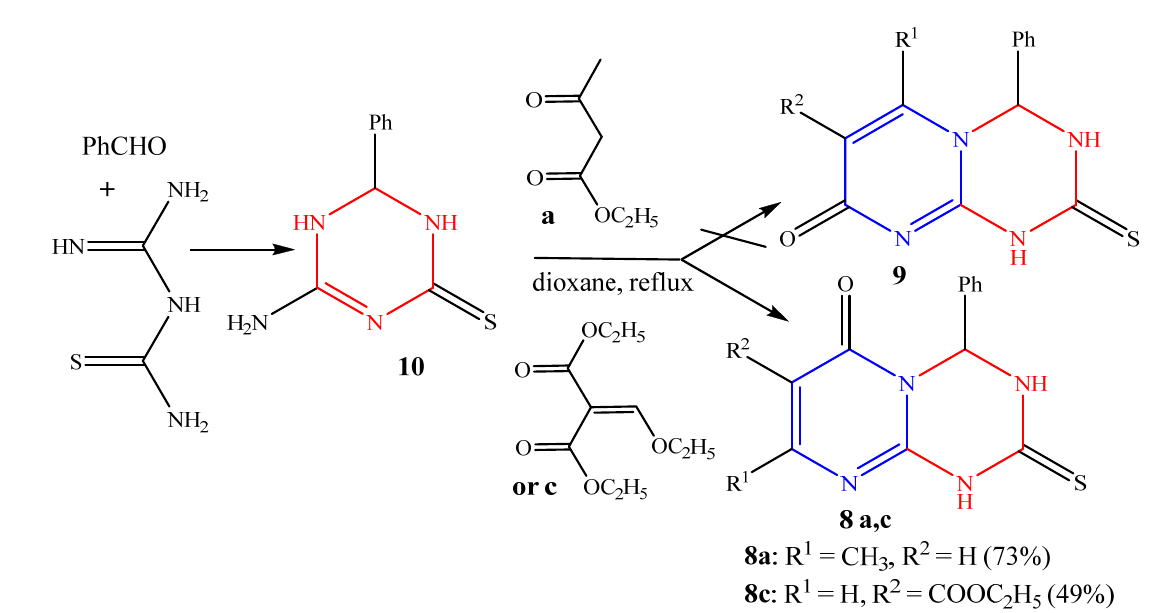
Figure 5. Reaction of 6-amino-4-phenyl-3,4-dihydro-1,3,5-triazine-2(1 H )-thione 10 with ethyl acetoacetate ( a ) and diethyl ethoxymethylenemalonate ( c ).